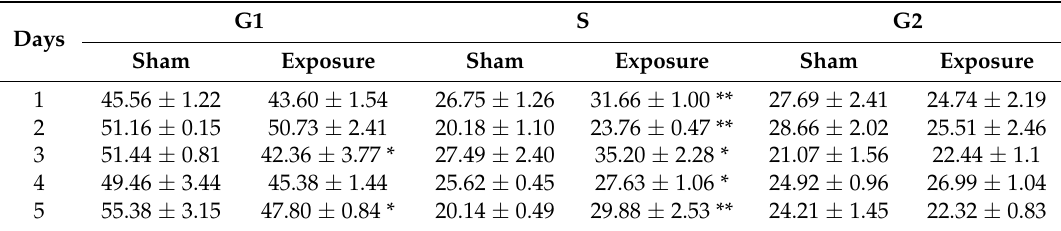
Table 1. Cell cycle distribution of TM3 cells after radiofrequency (RF) exposure.